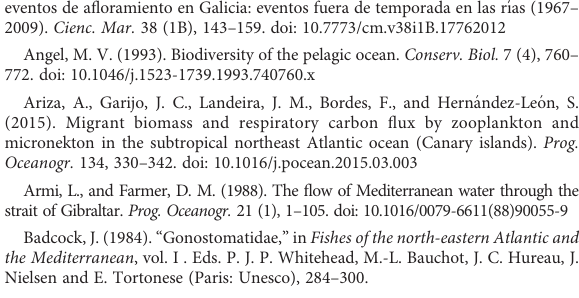
SUPPLEMENTARY FIGURE 3 Typical zonal scattering layer distributions observed using the hull- mounted 18 kHz echosounder. The colour scale is echo intensity (mean volumebackscatteringstrength,S v ,dBre1m -1 ).Leftpanelscorrespondto daytime observations, and right panels to night-time. Ping repetition interval was 2 seconds. At the c. 2.5 knots vessel speed that these observations were made (between net hauls), the 200 pings shown equate to about 500 m distance. The overlaid black curves represent the temperature pro fi les for simultaneous CTD casts (as shown in Figure 2).